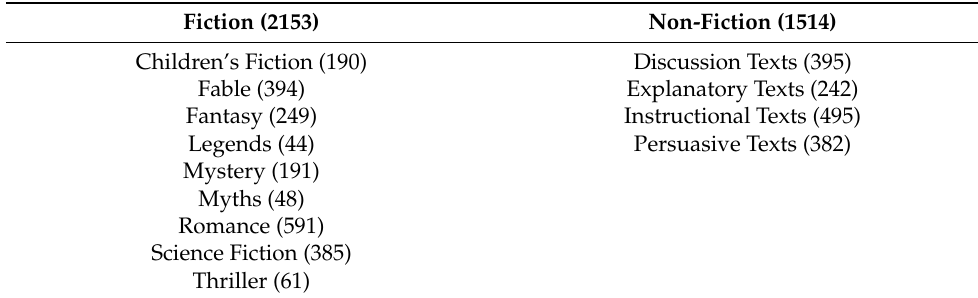
Table 2. Summary of the dataset of the